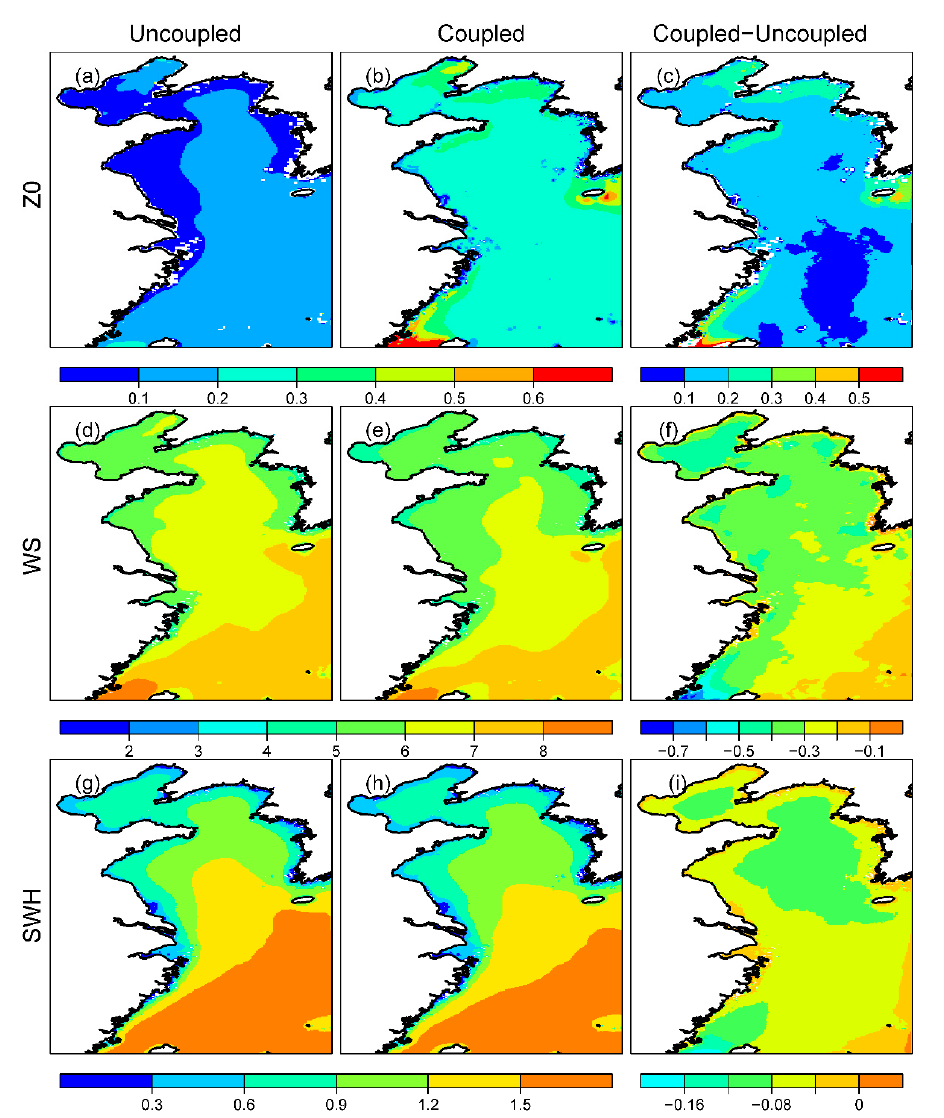
Figure 13. Annual mean roughness length (Z0, a , b , unit: mm), wind speed (WS, d – e , unit: m/s) and significant wave height (SWH, g , h , unit: m) for uncoupled and coupled simulations in 2010 and the differences between coupled and uncoupled simulations ( c , f , i ). Here, uncoupled represents CCLM for WS and WAM_C for SWH, coupled represents CCLM-WAM for WS and SWH. In the previous sections, we investigated the skills of the ERA5, coupled and uncoupled simulations in capturing intensities and the track of the strong typhoon Kompasu by comparing the